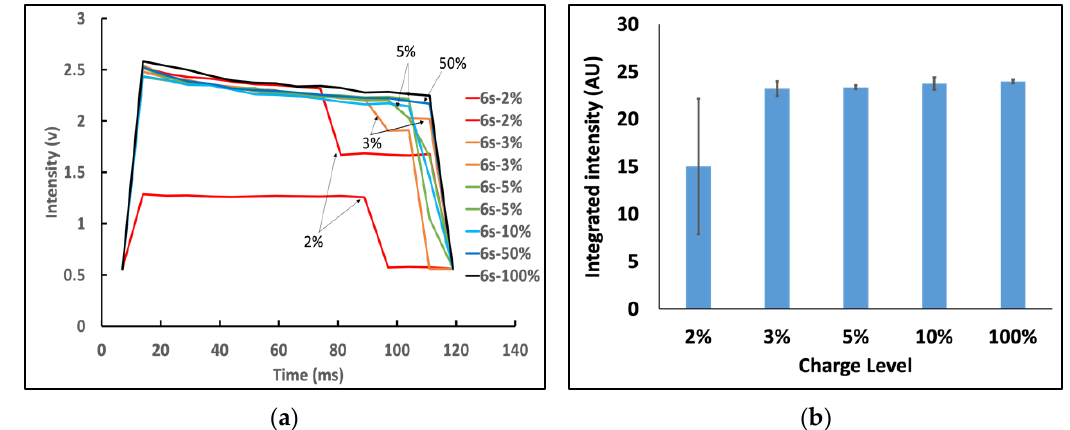
Figure 2. Effects of battery level on flash intensity and duration for unplugged iPhone 6s. ( a ) Variations of flash intensity at different charge levels. ( b ) Integrated flash intensity over the duration of flash. At high charge (>5%), flash duration and intensity were very consistent. However, at low charge (<5%), the flash intensity decreased and the duration became shorter. Flash intensities were measured at 437 nm, the highest peak in the flash LED emission spectrum (n = 3).